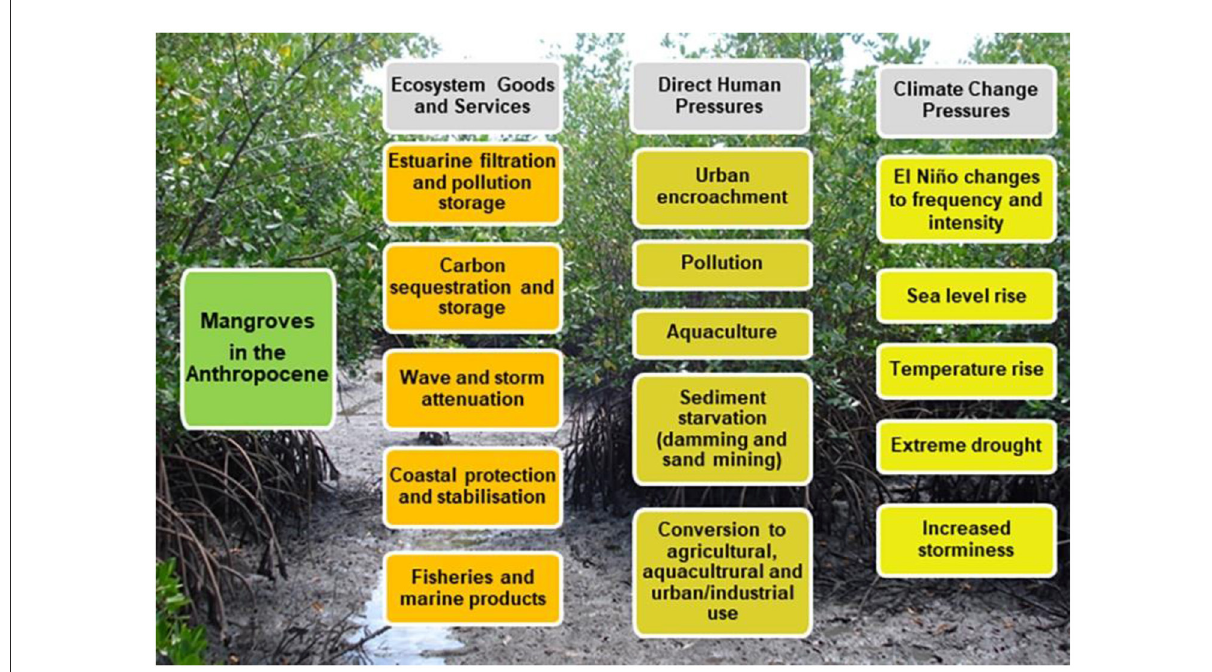
FIGURE1 Major challenges for mangrove ecosystems in the Anthropocene: as providers of goods and services and as receptor of impacts from direct and indirect environmental drivers of anthropogenic origin.